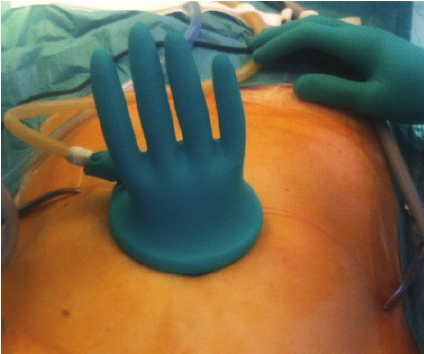
Figure 3: Induction of pneumoperitoneum.